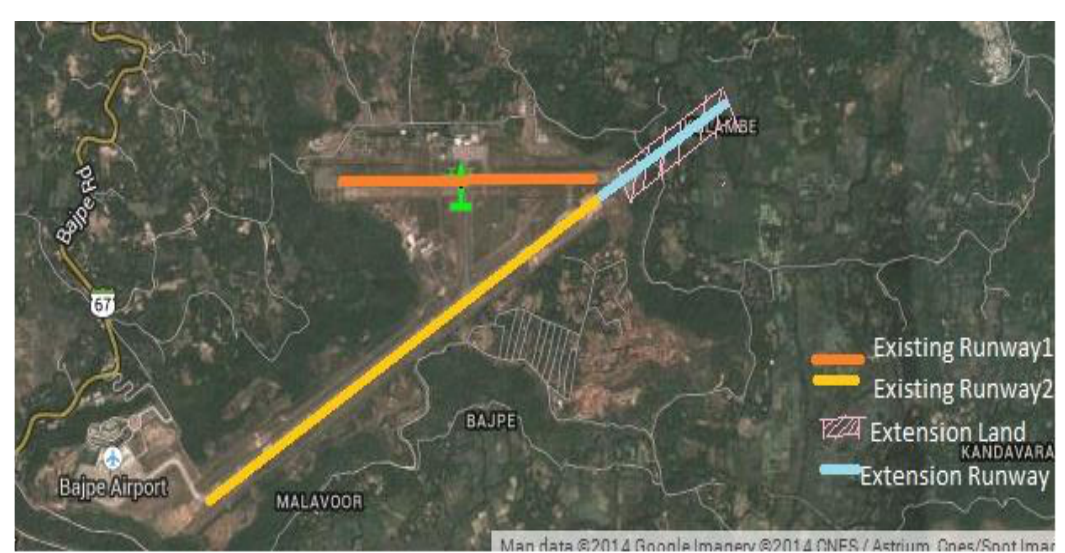
Fig .1. Map of Mangalore airport showing the existing runways and proposed extension runway.